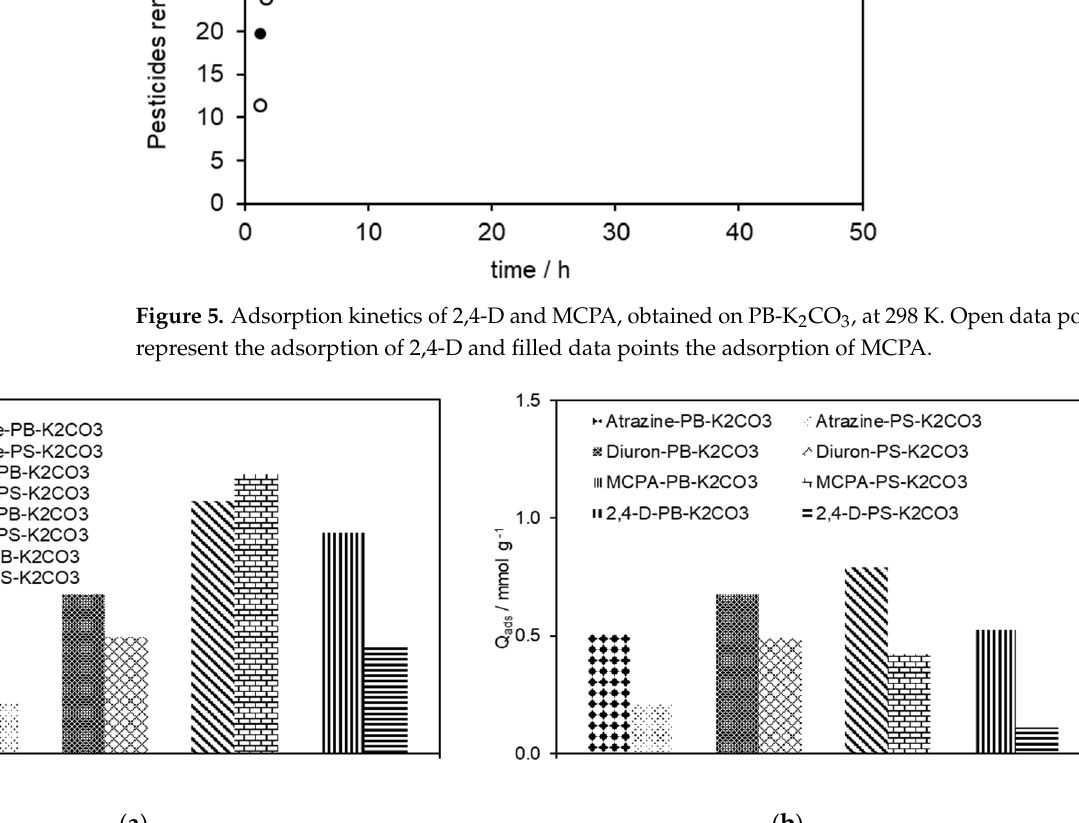
Figure 6. Maximum adsorption capacities obtained for the four pesticides on PB-K 2 CO 3 and PS-K 2 CO 3 . ( a ) Data concerning MCPA and 2,4-D were obtained from concentrated solutions. ( b ) Data concerning MCPA and 2,4-D were obtained from diluted solutions.